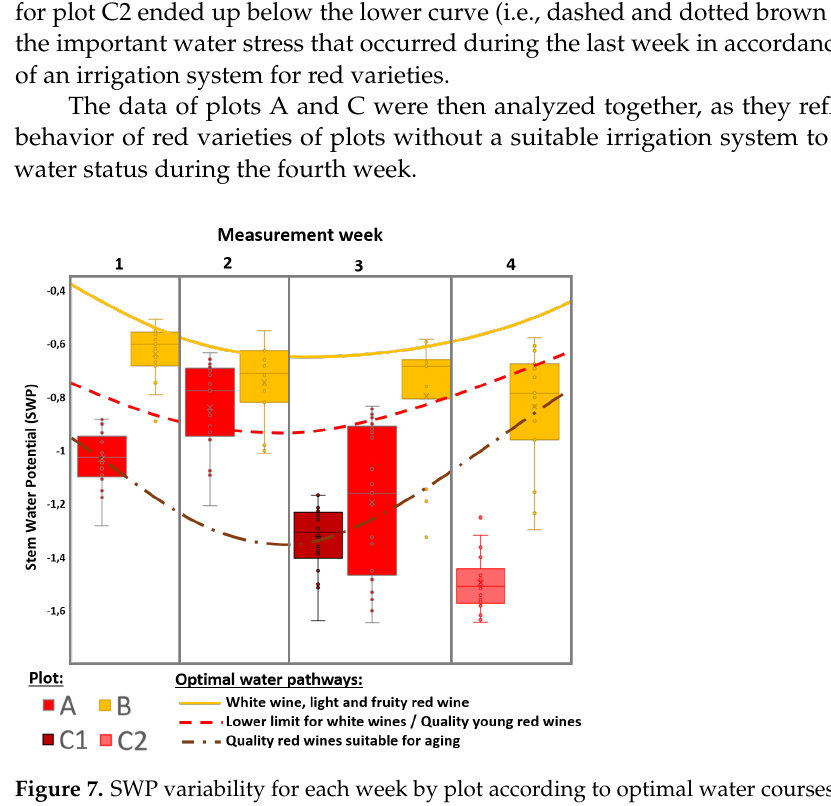
Figure 7. SWP variability for each week by plot according to optimal water courses (from Figure